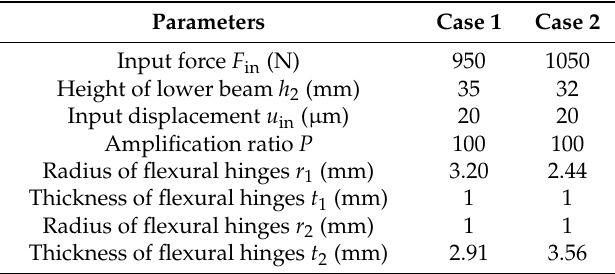
Table 4. Optimal results and parameters of symmetric circular flexural hinges under two